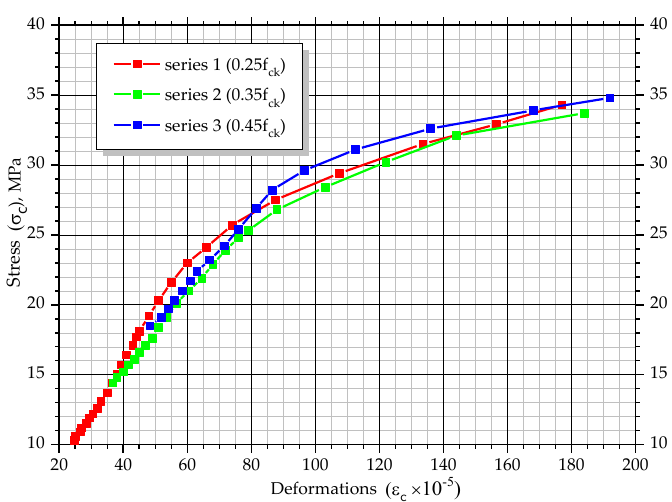
Figure 13. Average dependencies, σ c − ε c , in acid H 2 SO 4 . For prisms of series 3 and 4 with an initial stress level equal to σ c / f ck = 0.45 and σ c / f ck = 0.35, which were tested in water, almost no increase in deformations was observed. Fifty days after the beginning of the experiment, deformations reached 5.0–7.4 × 10 − 5 , whereas on the 89th day they decreased and were equal to 3.5–4.5 × 10 − 5 for series 3 and 4.2–5.8 × 10 − 5 and 2.5–3.0 × 10 − 5 for series 4, respectively. In prisms tested in the air and immersed in water, the stresses did not